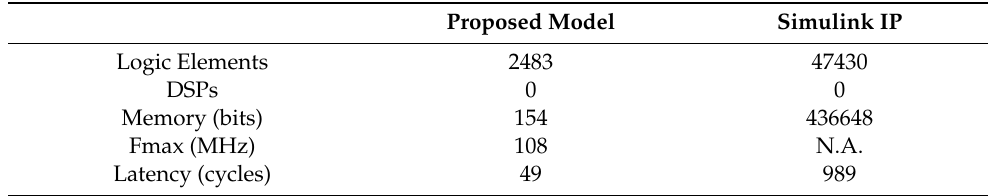
Table 3. Simulink accumulator resource usage, maximum frequency, and latency on Altera Cyclone 10 LP.